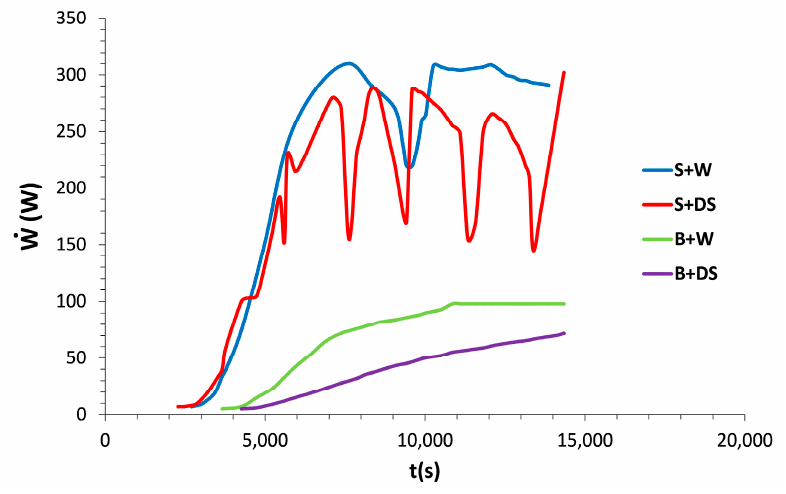
Figure 11. Power required for the evaporation of the liquid in the tray.